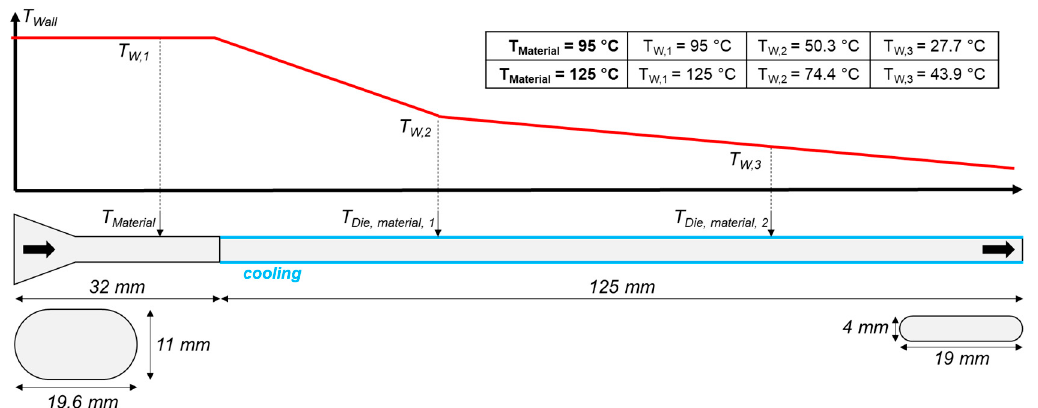
Figure 2. Modelling of the flow domain, which resembles the die section from extrusion trials, and the temperature profile.